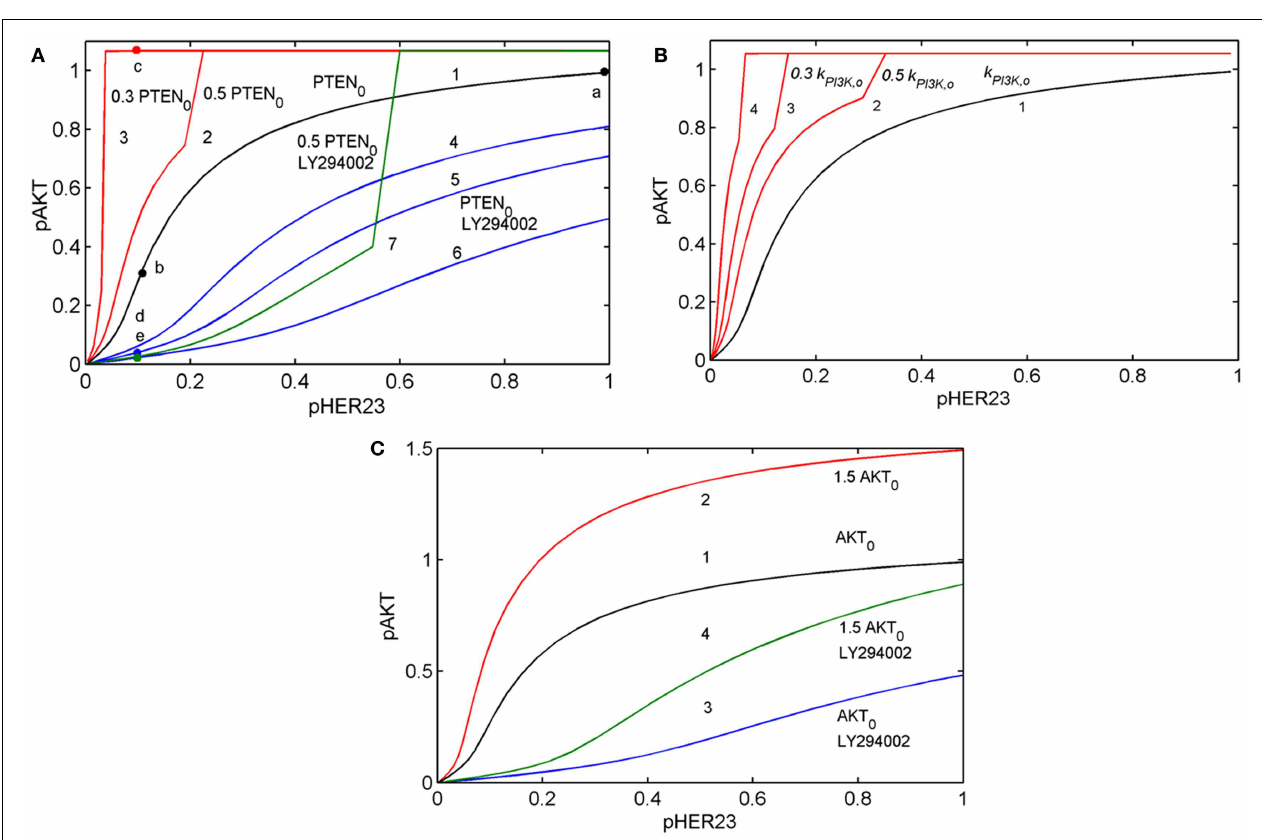
saturated p AKT signal ( p HER23 = 1), its inhibition by 100nM 2C4 ( p HER23 = 0.1), resistance to 2C4 at 50% PTEN loss ( p HER23 = 0.1), combined inhibition by 2C4 and LY294002 in the absence and presence of 50% PTEN loss ( p HER23 = 0.1), respectively. (B) Modification of R AKT by a change of PI3K activities, k PI3K : reference k PI3K,0 (line 1), 0.5 k PI3K,0 (line 2), 0.3 k PI3K,0 (line 3), and 0.1 k PI3K,0 (line 4). (C) Modification of R AKT by 50% overexpression of AKT: reference concentration AKT 0 (line 1) and 1.5 AKT 0 (line 2). Modification of R AKT by 1 µ M LY294002 at reference concentration of